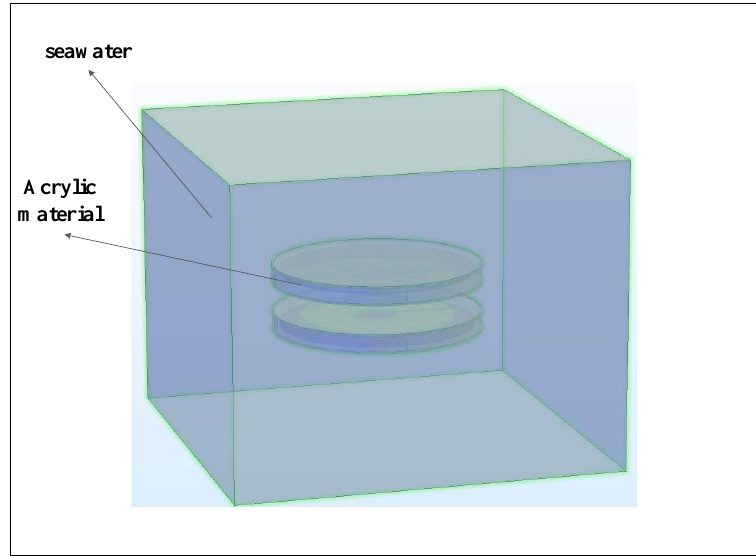
Figure 3. Building an IPT geometric model in the seawater environment .